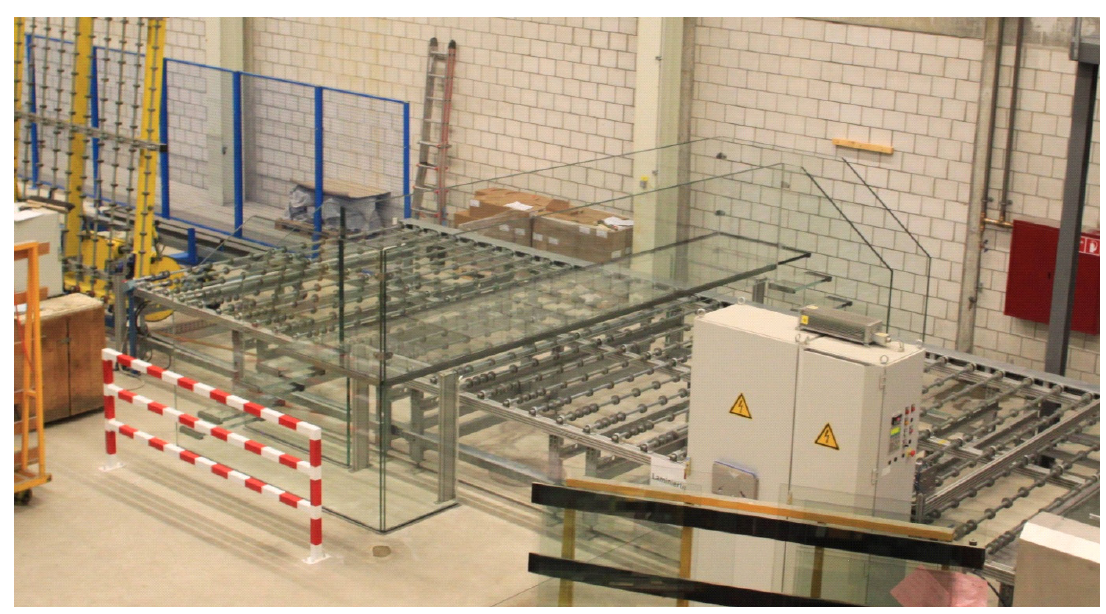
Fig. 5 Pilot Project of a full glass bridge with structurally bonded connection